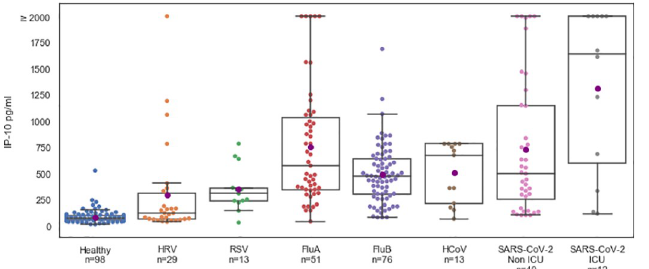
Fig 2. IP-10 levels are significantly higher in viral infections associated with pulmonary pathology. IP-10 levels in the internal medicine ward (non-ICU, n = 40) and ICU (n = 12) COVID-19 patients and in healthy subjects (n = 98) and virally infected patients (n = 182) with polymerase chain reaction-confirmed viral infections such as human rhinovirus (HRV), respiratory syncytial virus (RSV), influenza (Flu), and human coronavirus (HCoV). Each circle represents a patient. The black line denotes the group median and the purple circle corresponds to group mean. The box indicates patients with values between the 25 and 75 percentiles. The whiskers indicate patients with values between the 2.5 and the 97.5 percentiles. For the COVID-19 patients, IP-10 was measured using MeMed Key ™ at various time points and the first IP-10 measurement is shown.